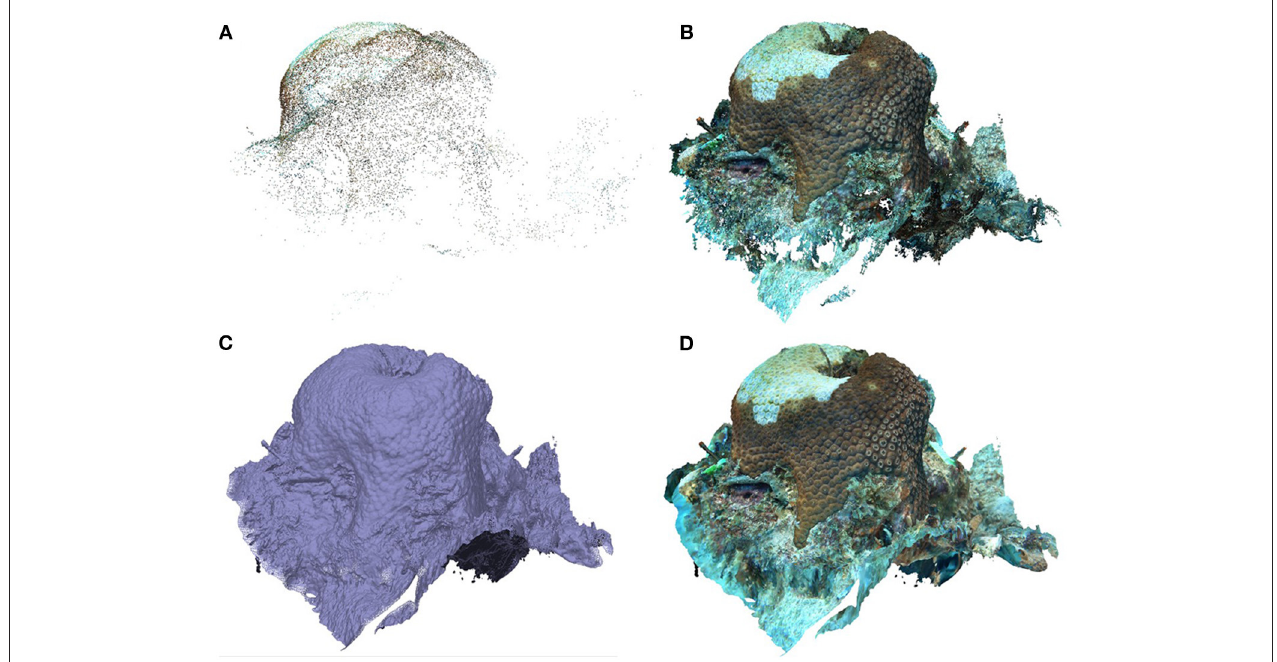
FIGURE 4 | Stages of building a 3D model. (A) Sparse point cloud. (B) Dense point cloud. (C) Mesh. (D) Textured